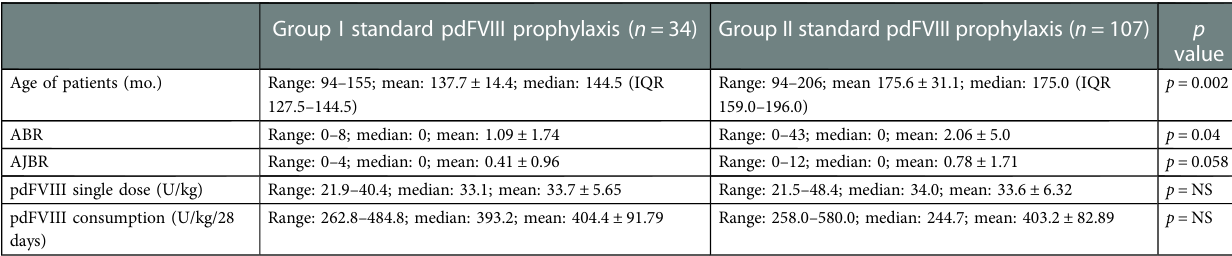
TABLE 2 Baseline patient characteristic prior to switching from pdFVIII to